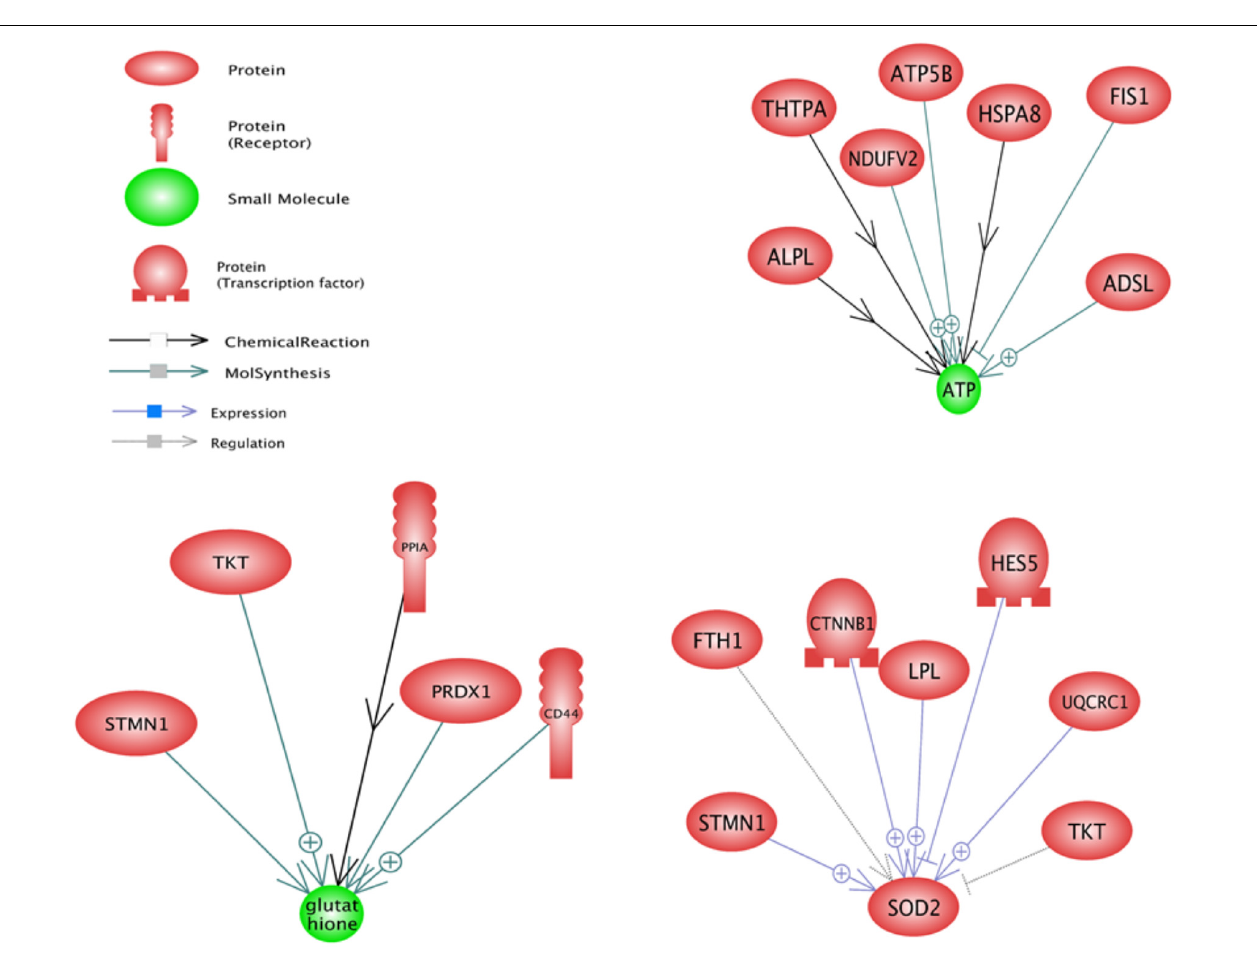
FIGURE 3 | Significant upstream sub-networks constructed by differentially expressed genes between pre-peak and post-peak milk production. L Represents positive-regulated and (cid:96) represents negative-regulated. Glutathione, SOD2, and ATP were the three top important